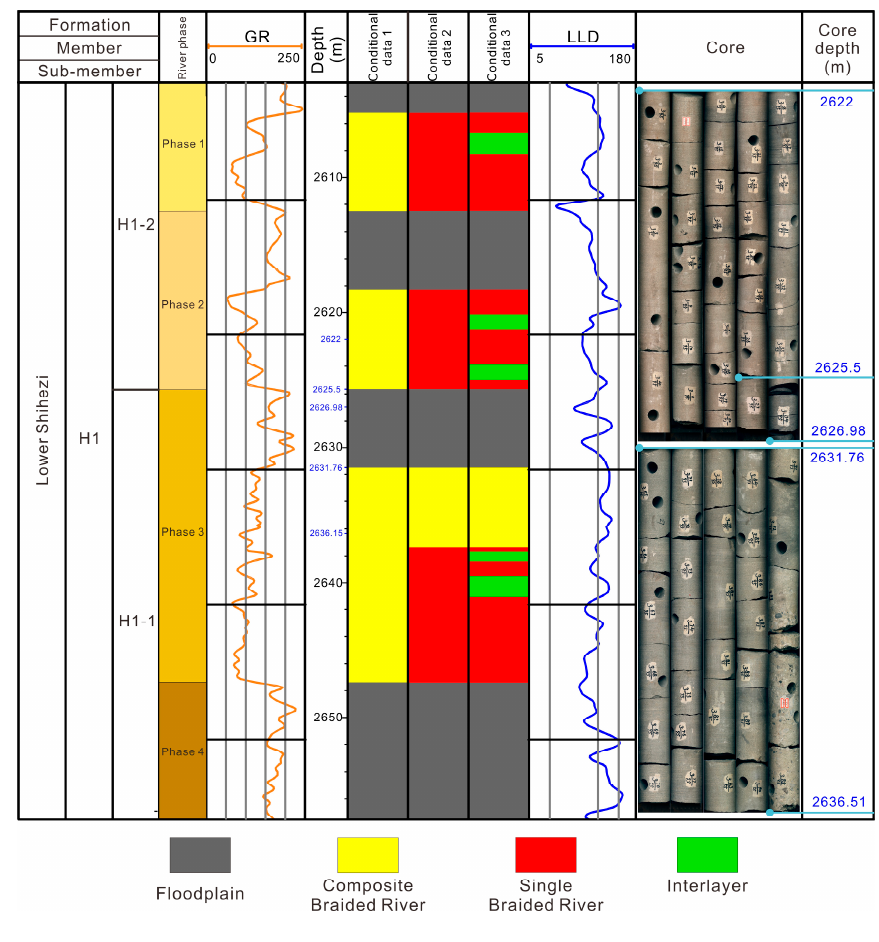
Figure 6. Division of 3 sets of conditional data based on logging curves data and core analysis.